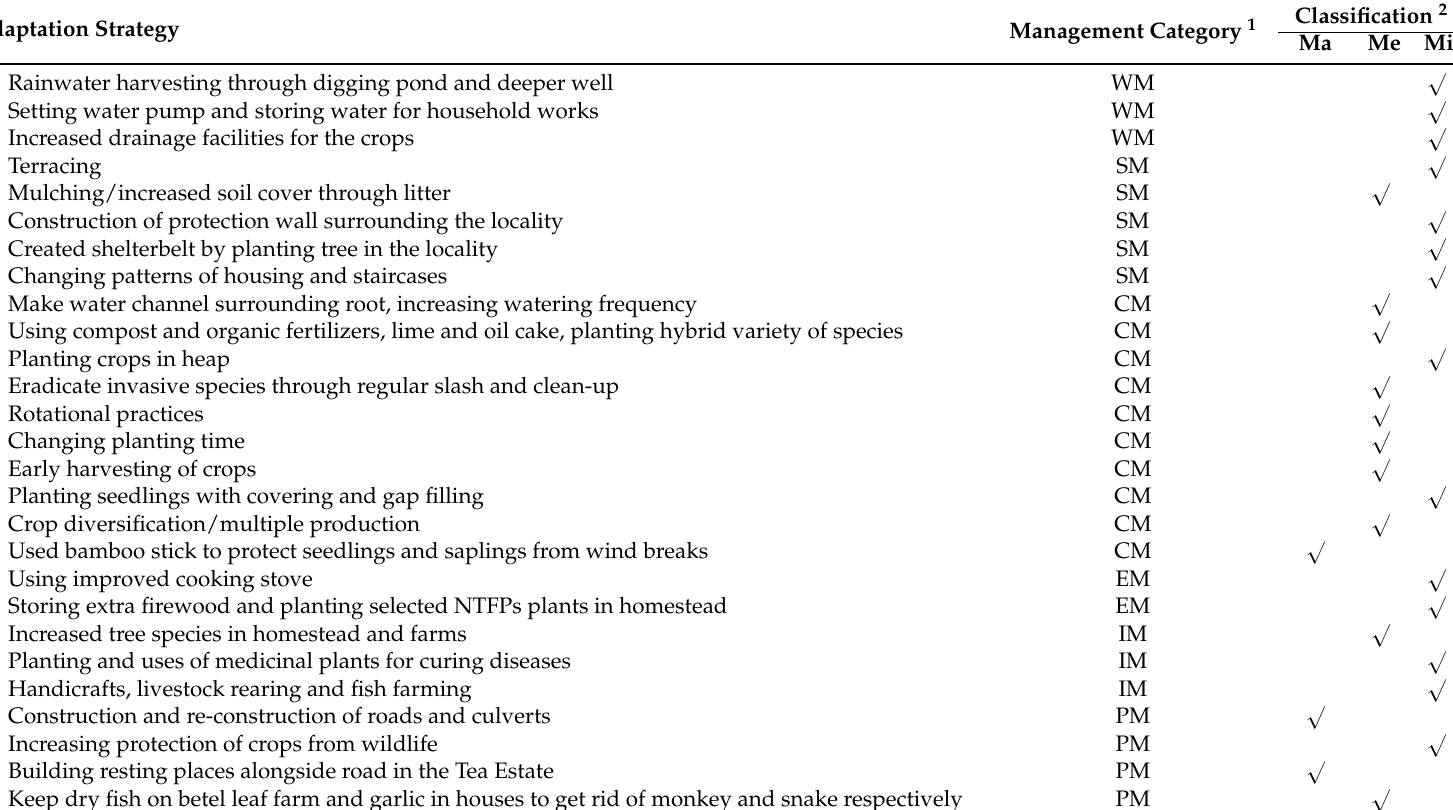
Table 5. Management categories and classification of adaptation